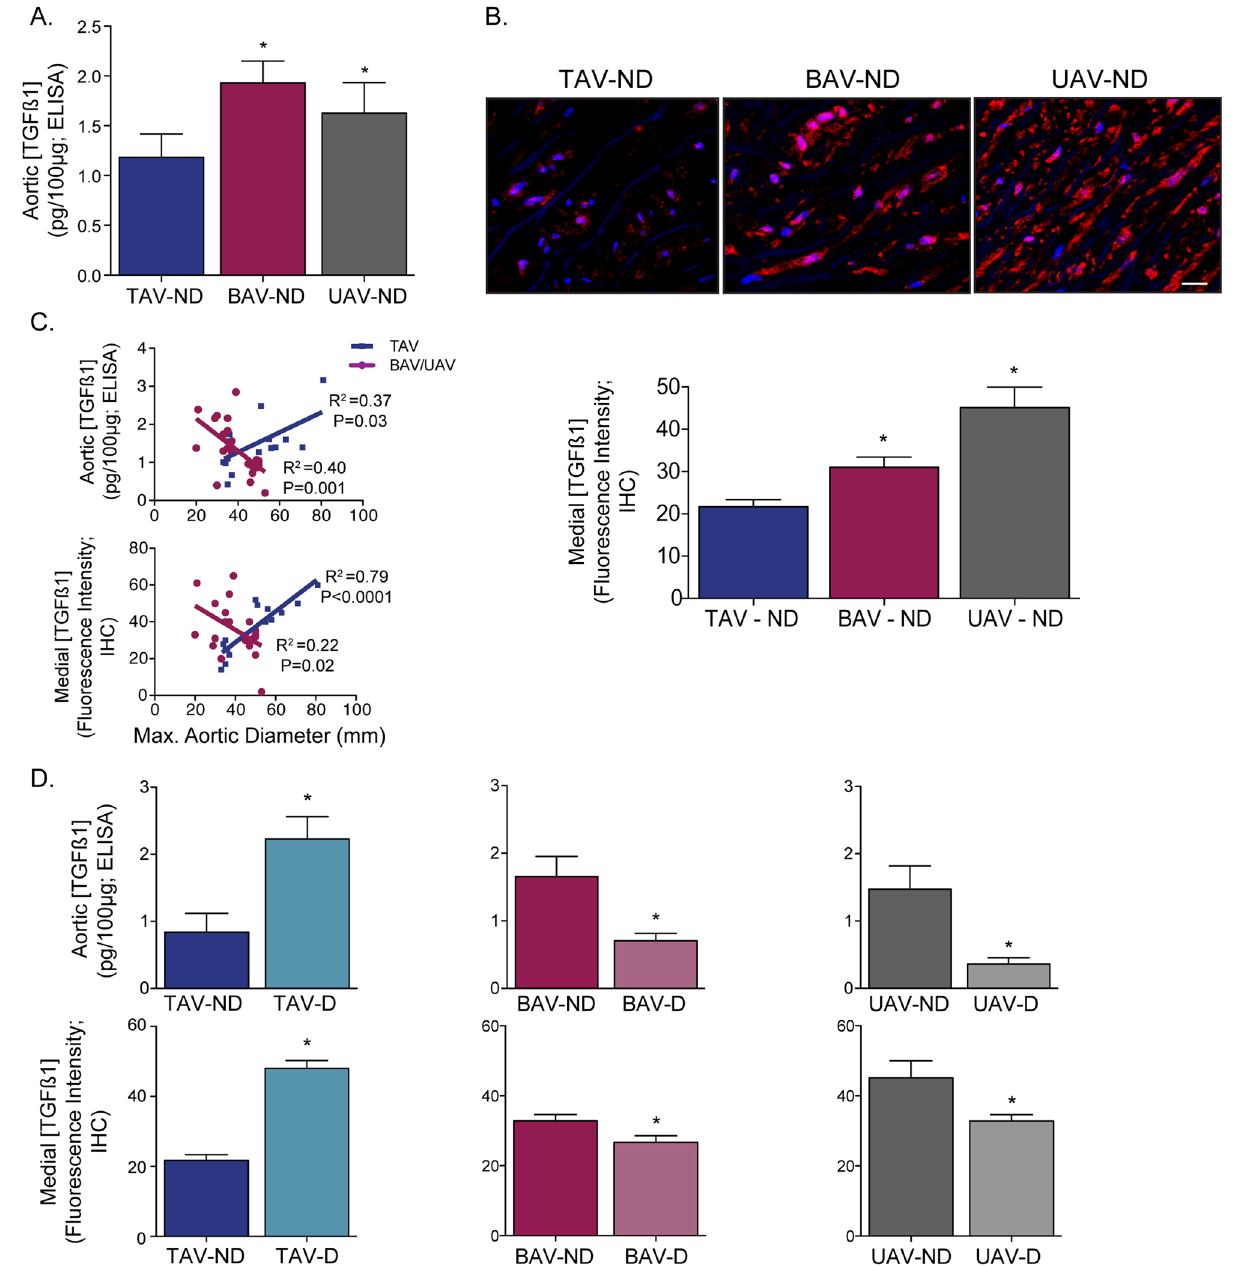
Figure 1. Transforming growth factor-beta (TGFß) ligand concentration correlates to ascending aortic diameter in tricuspid (TAV), but not bicuspid (BAV) or unicuspid (UAV) aortic valve patients. ( A ) Graph depicting the TGFß1 ligand concentration in non-dilated (ND) aortas from individuals with a TAV, BAV or UAV. ( B ) Fluorescent micrographs (top; blue = DAPI, red = TGFß1) and corresponding graph (bottom) depicting the TGFß1 concentration in the aortic media from individuals with ND aortas and either a TAV, BAV or UAV. ( C ) Graphs depicting the relationship between TGFß ligand concentration (whole aorta: top, media: bottom) and maximal ascending aortic diameter in TAV (blue) and BAV/UAV (pink) aortas. ( D ) Graphs depicting the TGFß1 ligand concentration (whole aorta: top, media: bottom) in ND and D aortas from individuals with a TAV, BAV or UAV. *P < 0.05. IHC = immunohistochemistry. Scalebar = 20